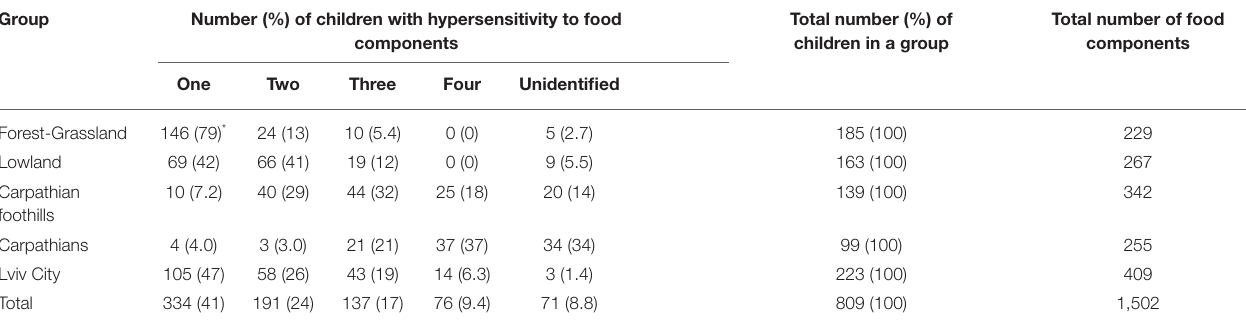
Total number (%) of children in a